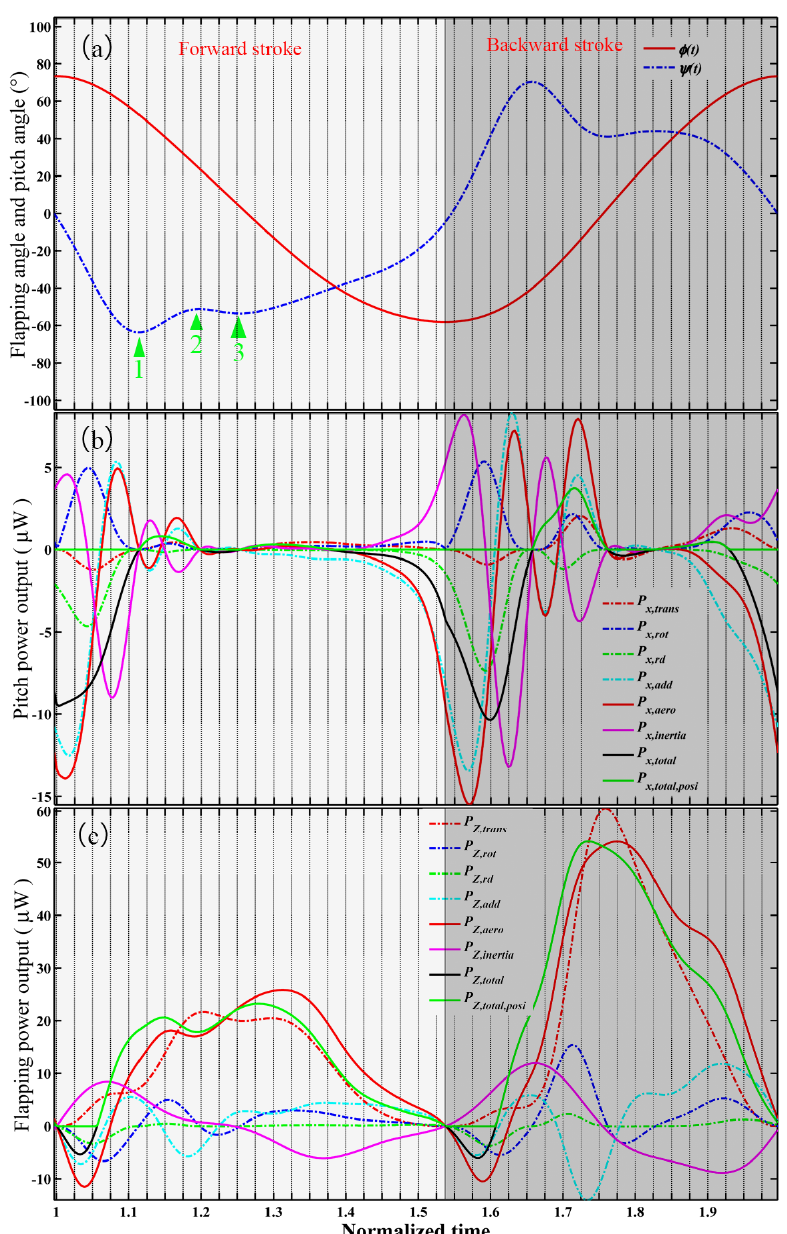
Figure 7. The approximate hovering steady wingbeat motion ( a ), pitch and flapping power output of single wing ( b , c ) for optimal wing geometry parameters (WGP).